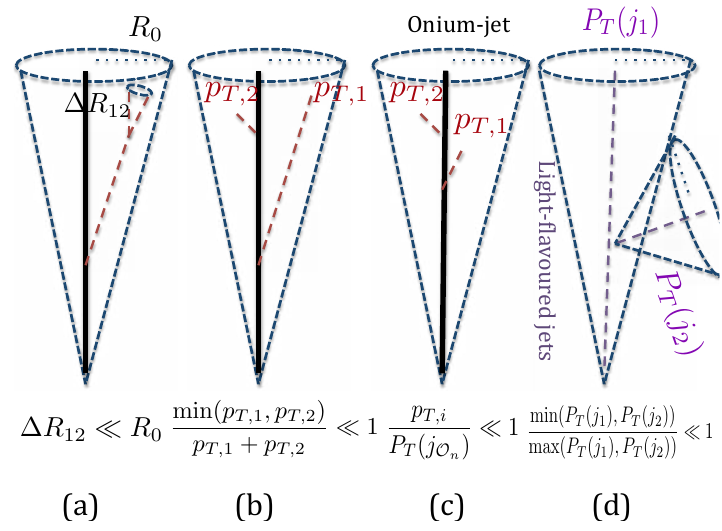
Figure 5 . Infrared unsafe configurations to be considered in inclusive quarkonium production, where the first 3 subfigures are for the onium jet j